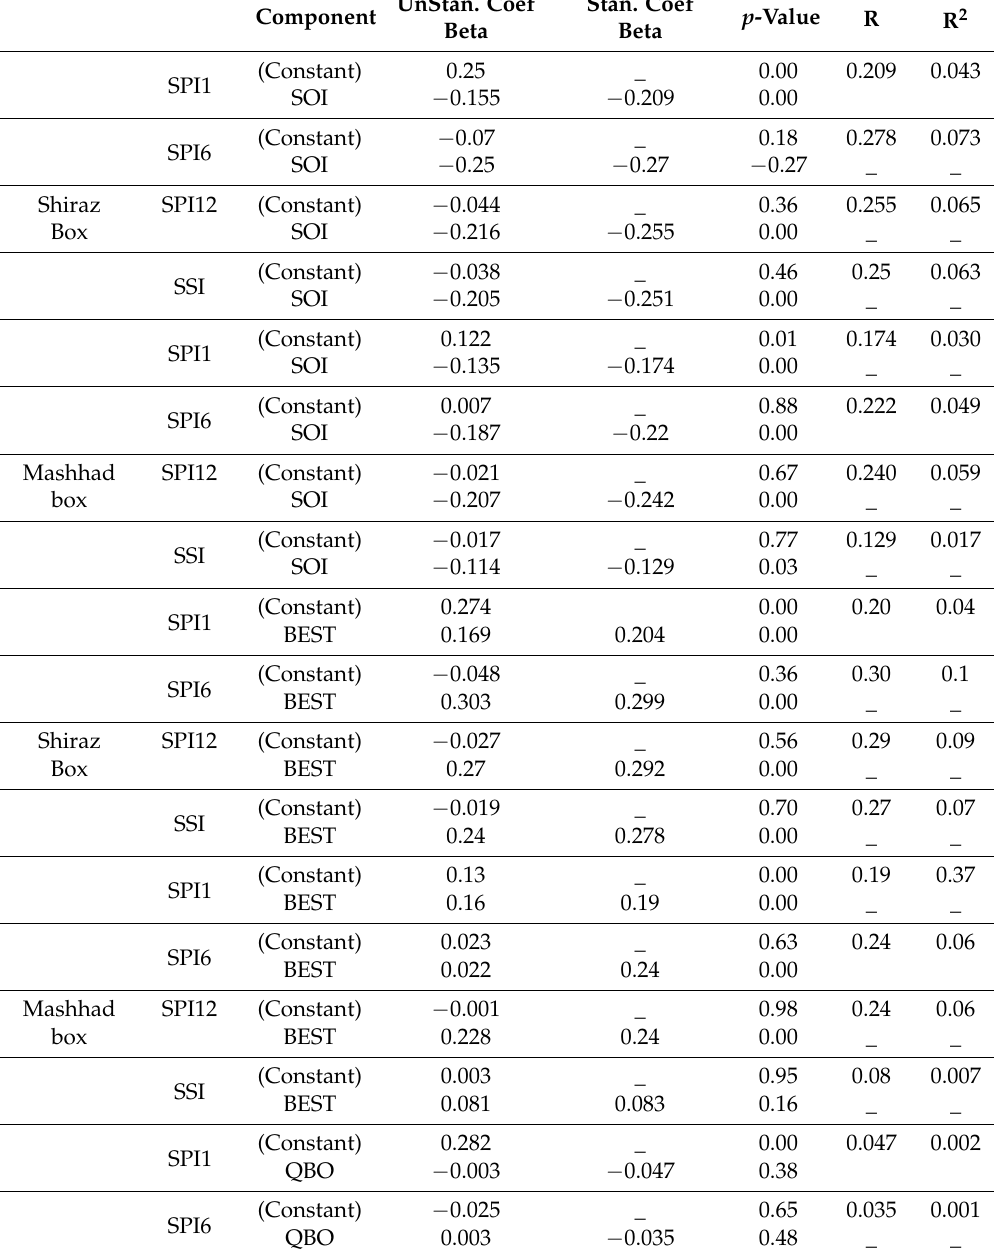
Table 3. Regression analysis between BEST, SOI, NAO, and QBO indices and 1-month, 6-month, and 12-month SPI and SSI hydrological drought index in the Mashhad and Shiraz boxes UnStan. Coef Stan. Component